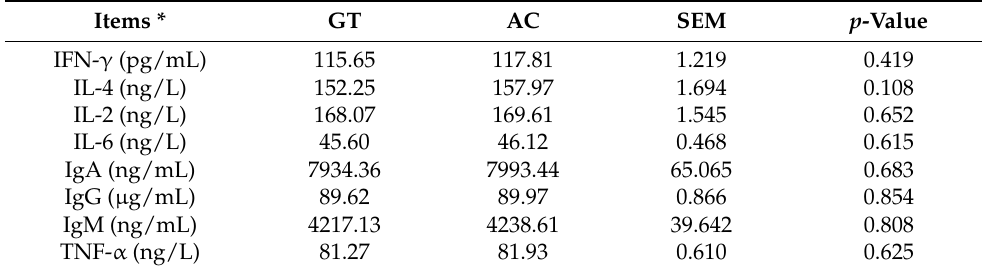
Table 5. Inflammatory cytokine serum levels in different groups after dietary